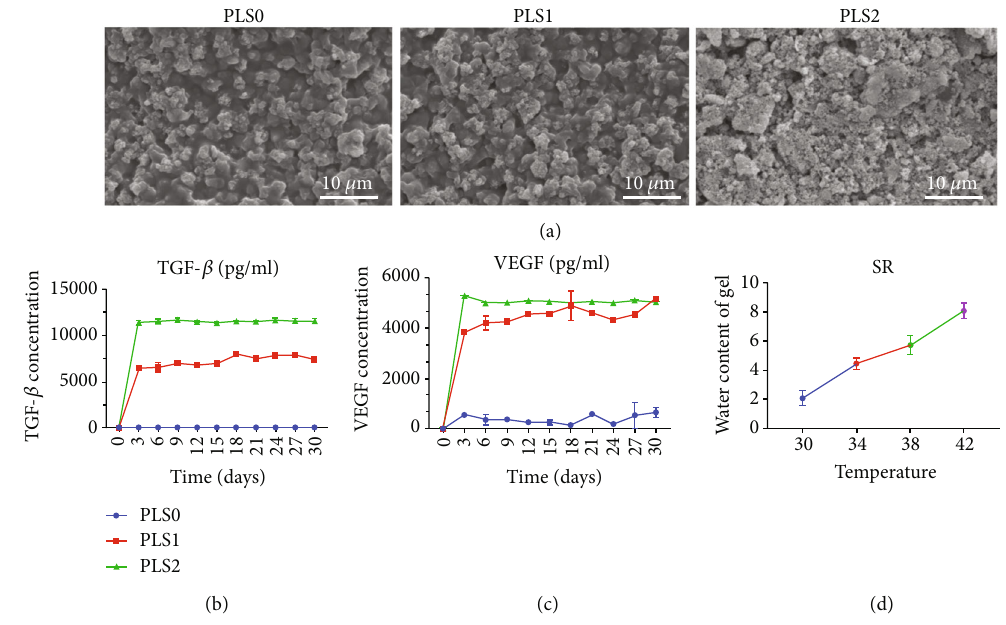
Figure 1: (a) Representative SEM images showing the structure of lyophilized thermosensitive hydrogel. (b, c) Release of growth factors from the loaded sPL hydrogel. (d) Temperature-dependent change in water